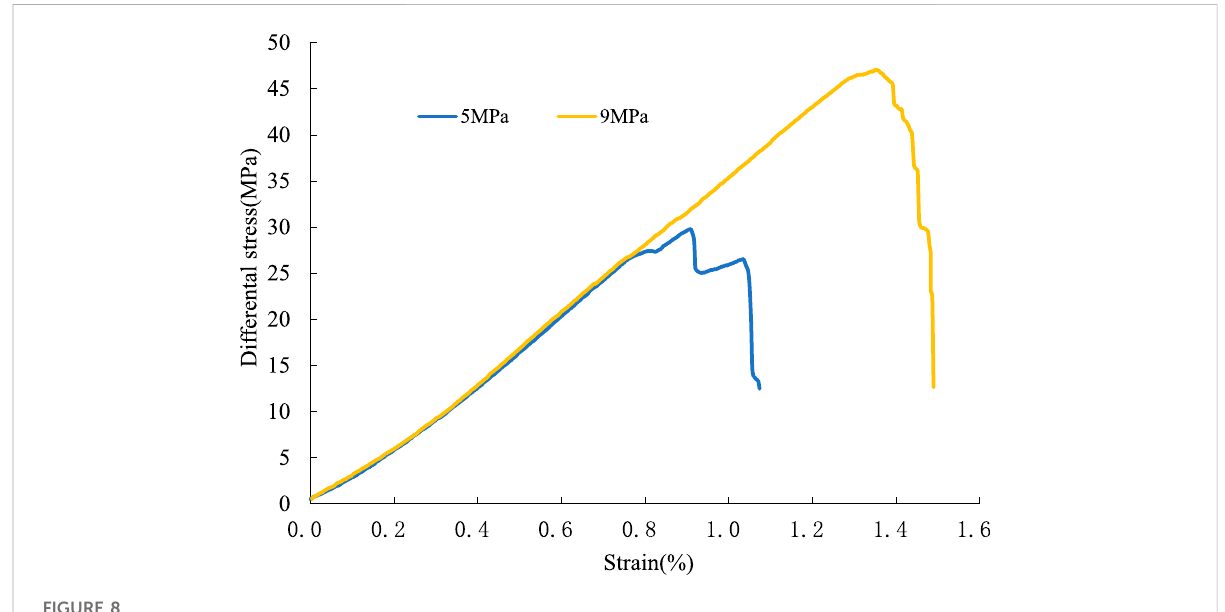
FIGURE 8 Stress-strain curves of coal samples at different con fi ning pressures.